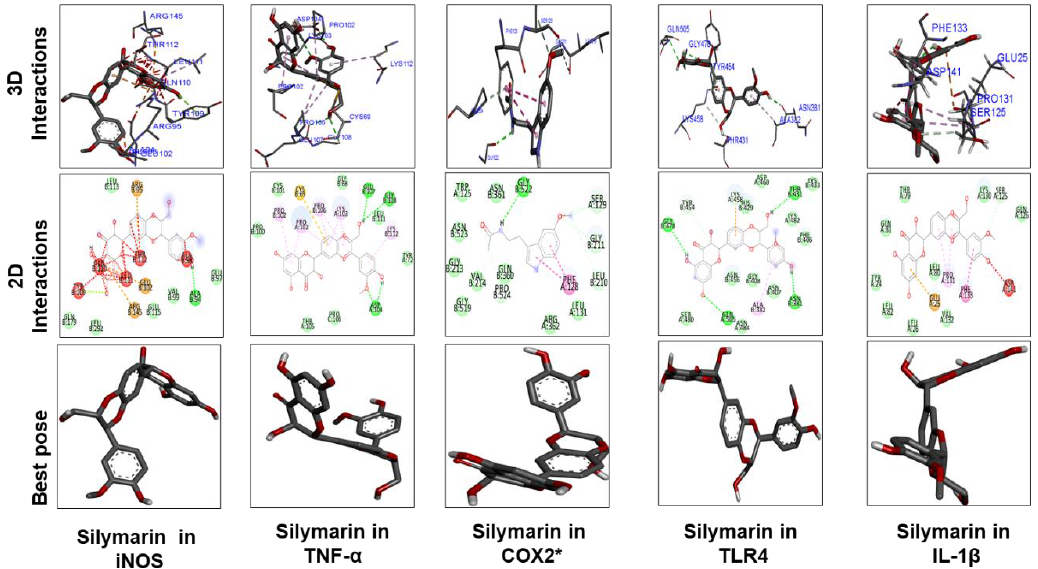
Figure 11. The different panels represent the docking analysis and best pose of silymarin that fitted to iNOS, TNFα, COX2, TLR4, and IL-1β. Both 2D and 3D shapes of the drug–receptor complex were visualized by DSV.